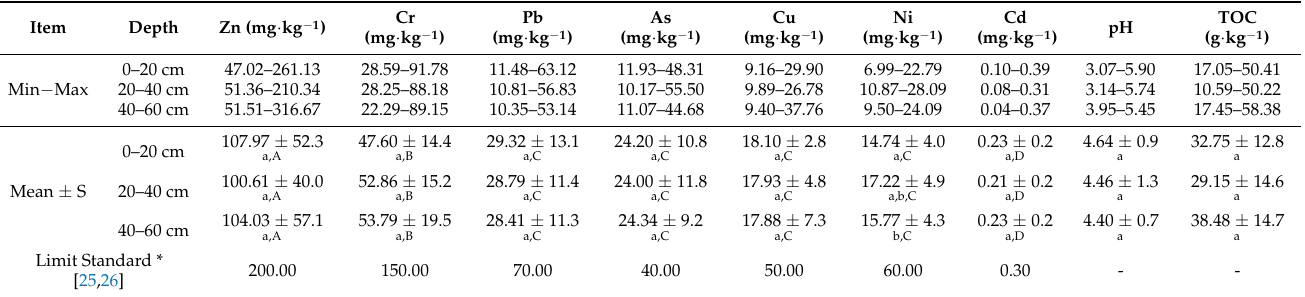
Table 3. Heavy metal concentrations, pH values, and total organic carbon (TOC) contents of soil samples from different depths in An-tea